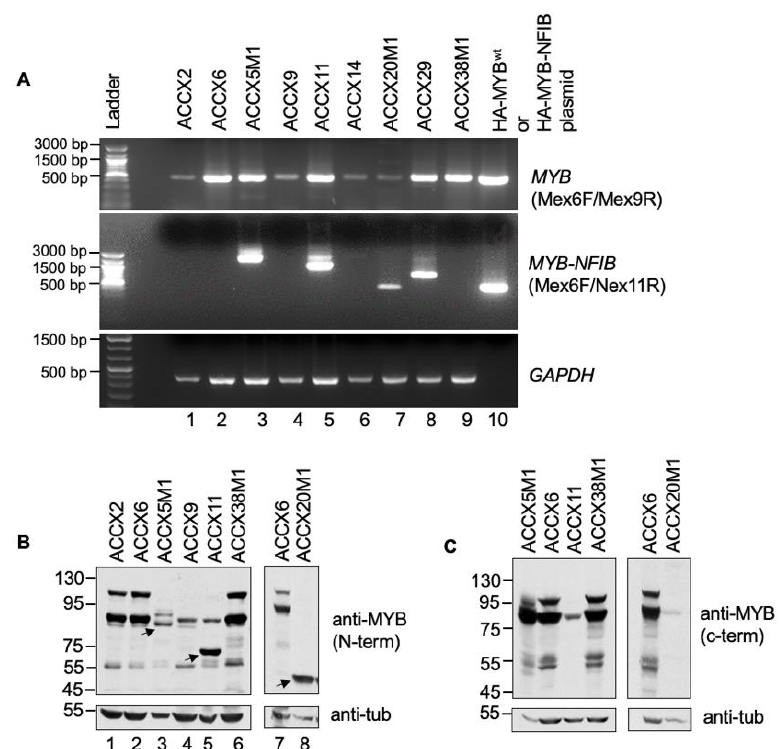
Figure 2. Expression of MYB and MYB-NFIB fusion in ACCXs. ( A ). RNA extracted from the indicated ACCXs were evaluated for expression of MYB-NFIB fusion or MYB wt by RT-PCR. HA-tagged MYB wt or HA-MYB-NFIB plasmid cDNA were included for reference control. GAPDH was used as input control. ( B ). Protein lysates from ACCXs were analyzed using an antibody that recognizes an N- terminal epitope of MYB. Arrows indicate smaller MYB bands. They correlate with the presence of MYB-NFIB product detected in “A” and likely represent MYB-NFIB fusion protein. ( C ). Protein lysates as in “B” were analyzed using an antibody that recognizes a C-terminal epitope of MYB. Note that the smaller MYB band from “B” is